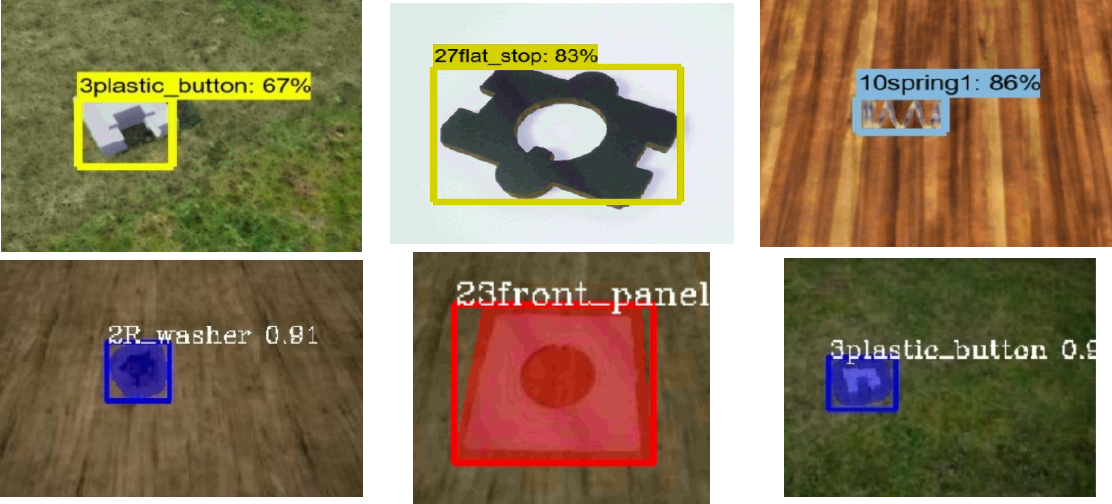
Figure 14. Inference experiments with the SSD trained model ( top ) and instance segmentation ( bottom ).